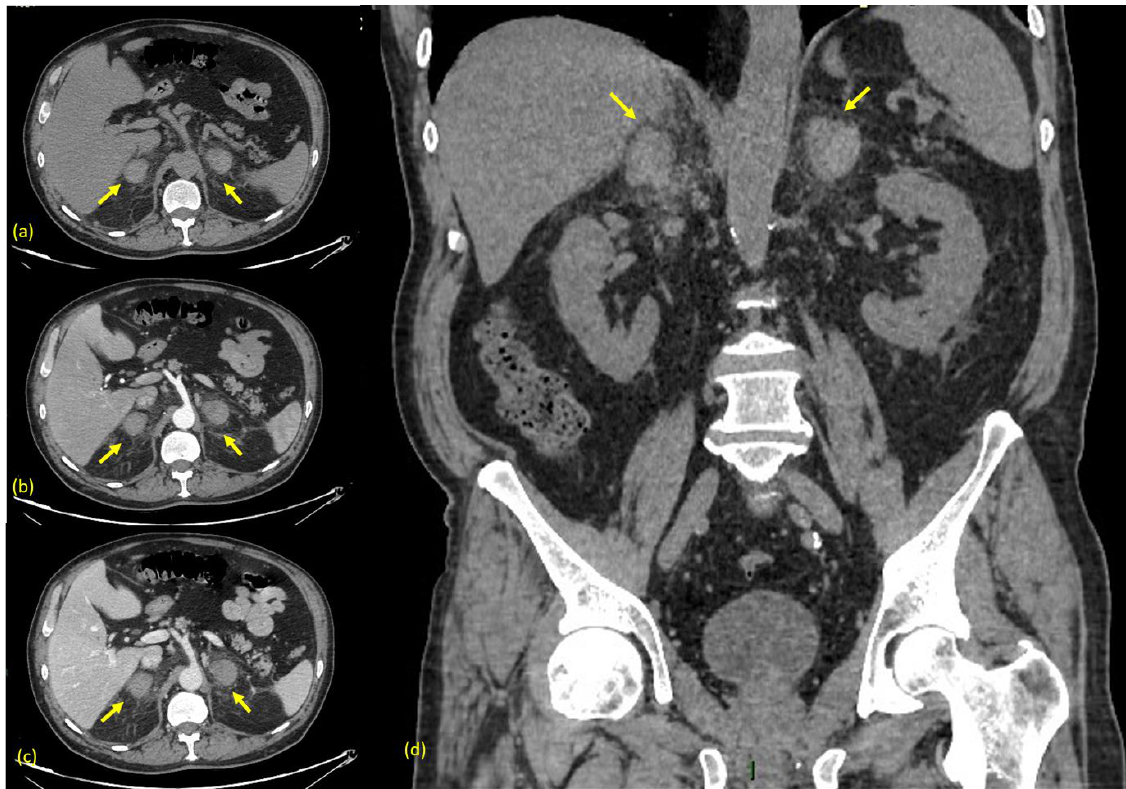
Figure 2. ( a ) CT axial non-contrast phase. ( b ) CT axial post-contrast arterial phase. ( c ) CT axial post-contrast portal venous phase. ( d ) CT coronal non-contrast phase. Arrows indicate the adrenal glands. The non-contrast phase demonstrates slightly hyperdense round masses with fuzzy margins and diffuse swelling in both adrenal glands, in association with inflammatory changes in the sur-rounding retroperitoneal fat, which is strongly suggestive of bilateral adrenal hemorrhage. After the intravenous contrast, no contrast blushes are shown, suggesting no evidence of active bleeding.